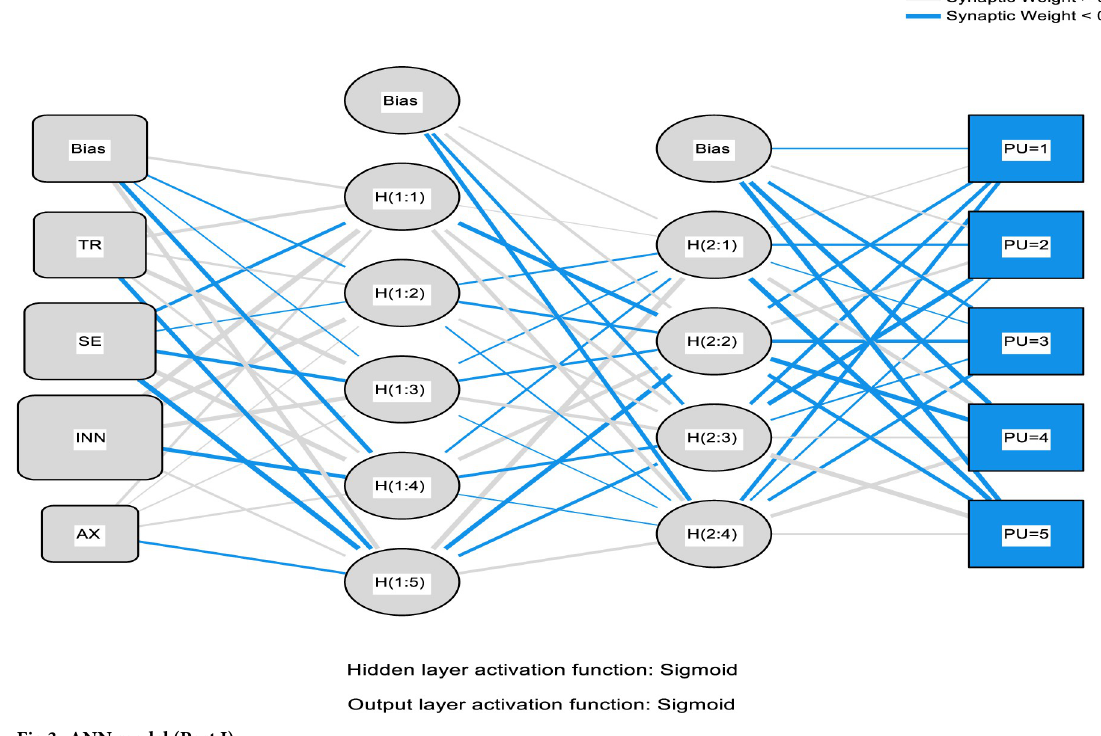
Fig 3. ANN model (Part